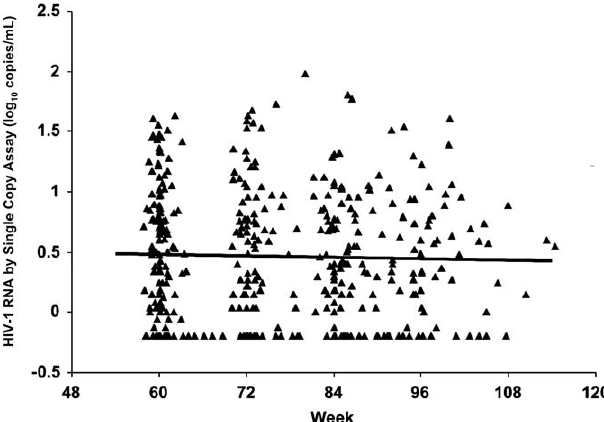
Figure 4. HIV-1 RNA Levels Over 50 wk of Suppressive Antiretroviral Therapy Plasma samples from patients in both arms of the M98–863 trial with viremia suppressed to , 50 copies/ml during weeks 60–110 were subjected to SCA analysis. HIV-1 RNA levels for each patient are presented here as a function of weeks on